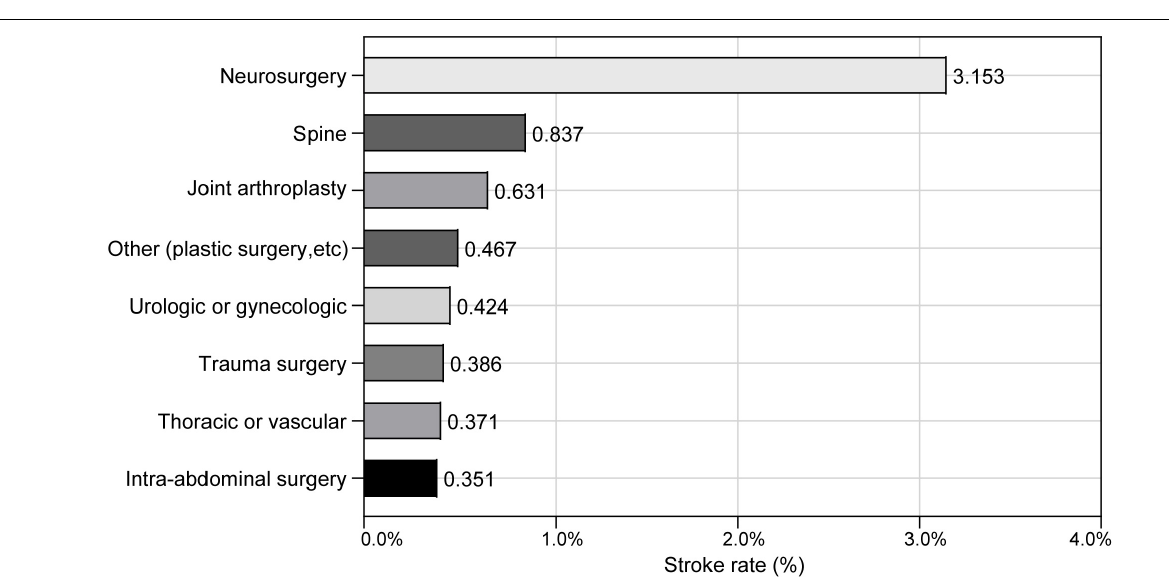
FIGURE 2 | Distribution of propensity scores before and after matching.